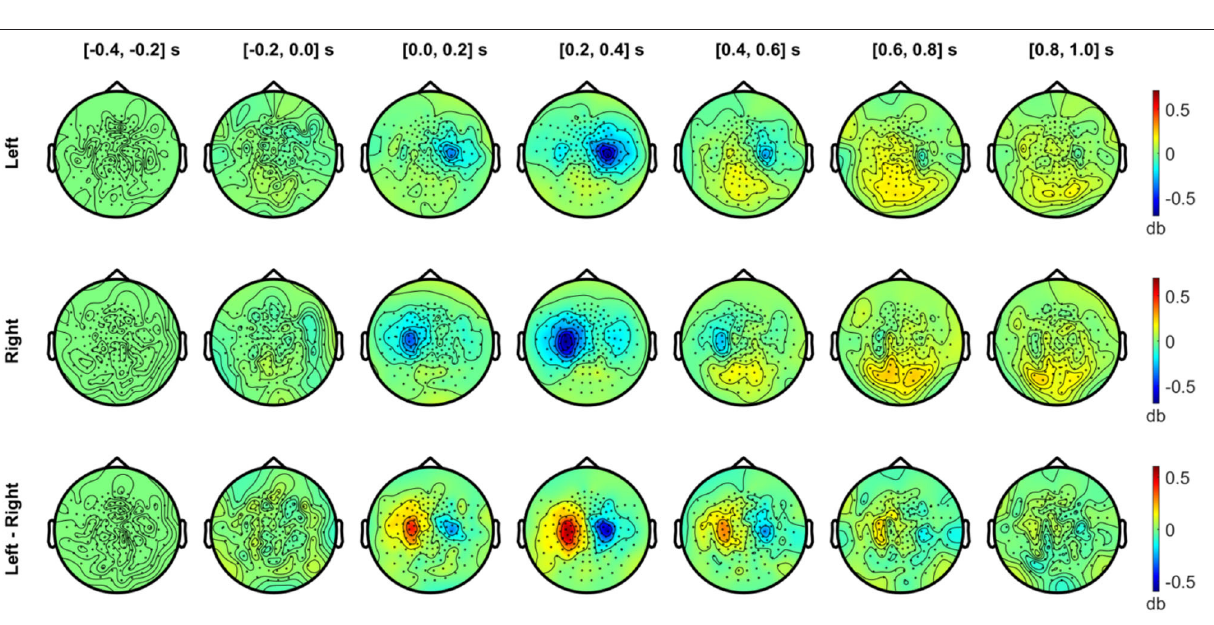
complicated folding structure of SII areas (Hari et al.,